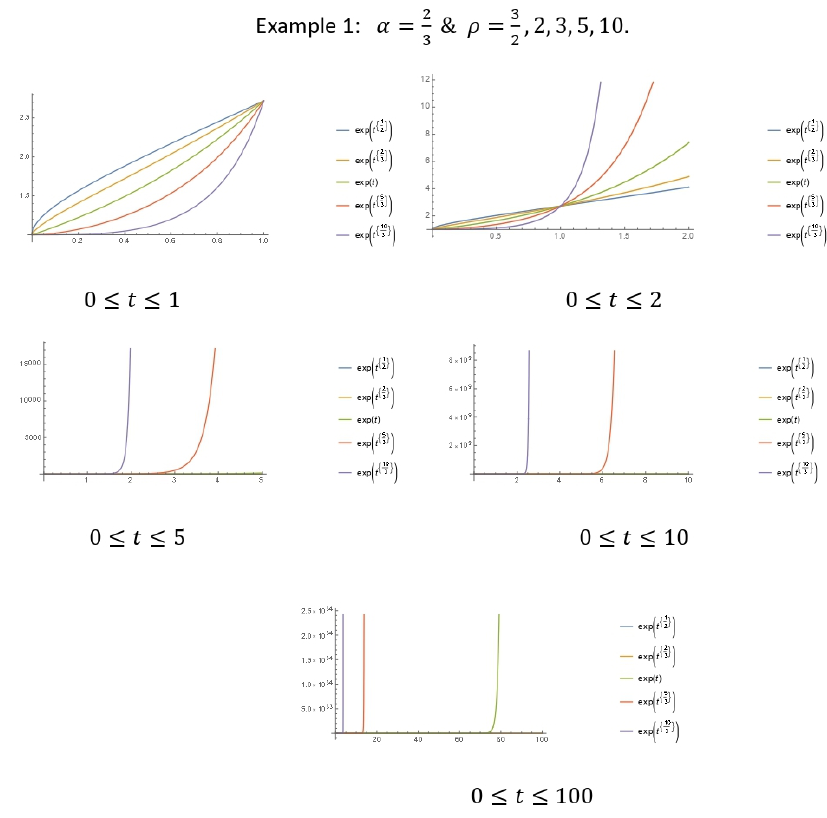
Figure 1. Graphical illustration of the energy growth